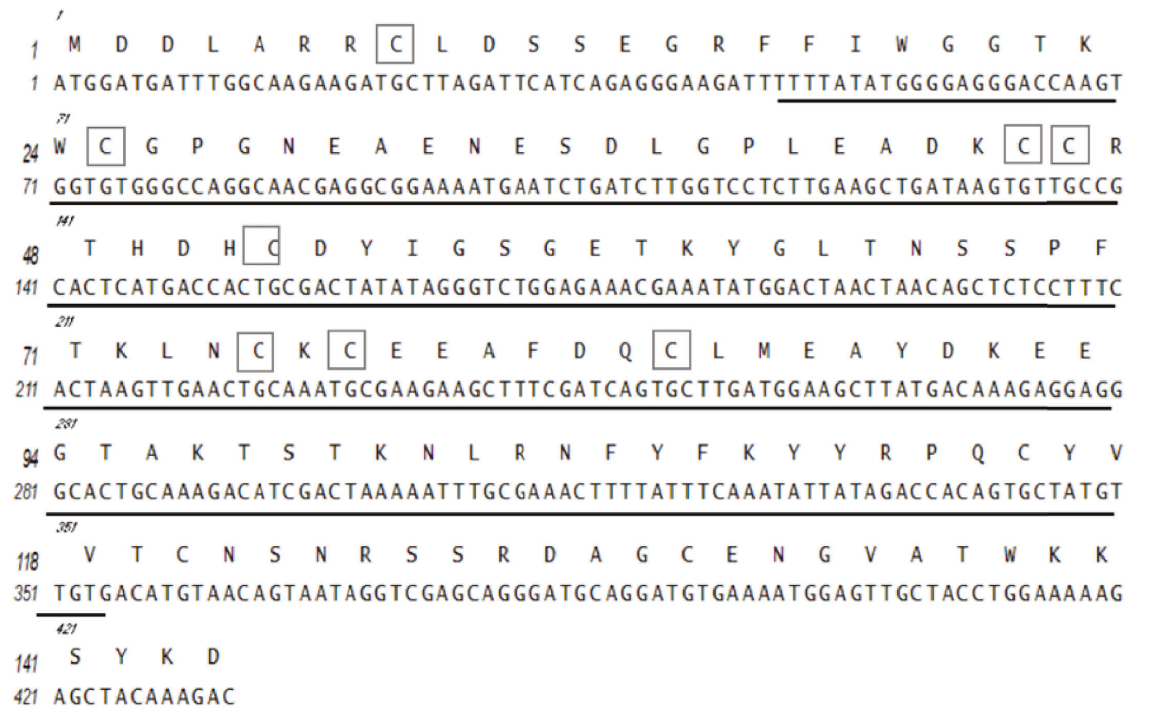
superfamily have been 2